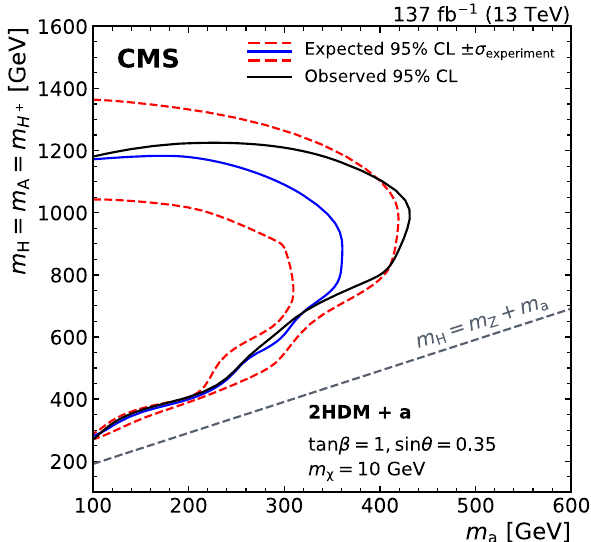
Fig. 8 The 95% CL upper limits on the 2HDM+ a model with the mixing angles set to tan β = 1 and sin θ = 0 . 35 and with a DM particle mass of m χ = 10GeV. The limits are shown as a function of the heavy Higgs boson and the pseudoscalar masses